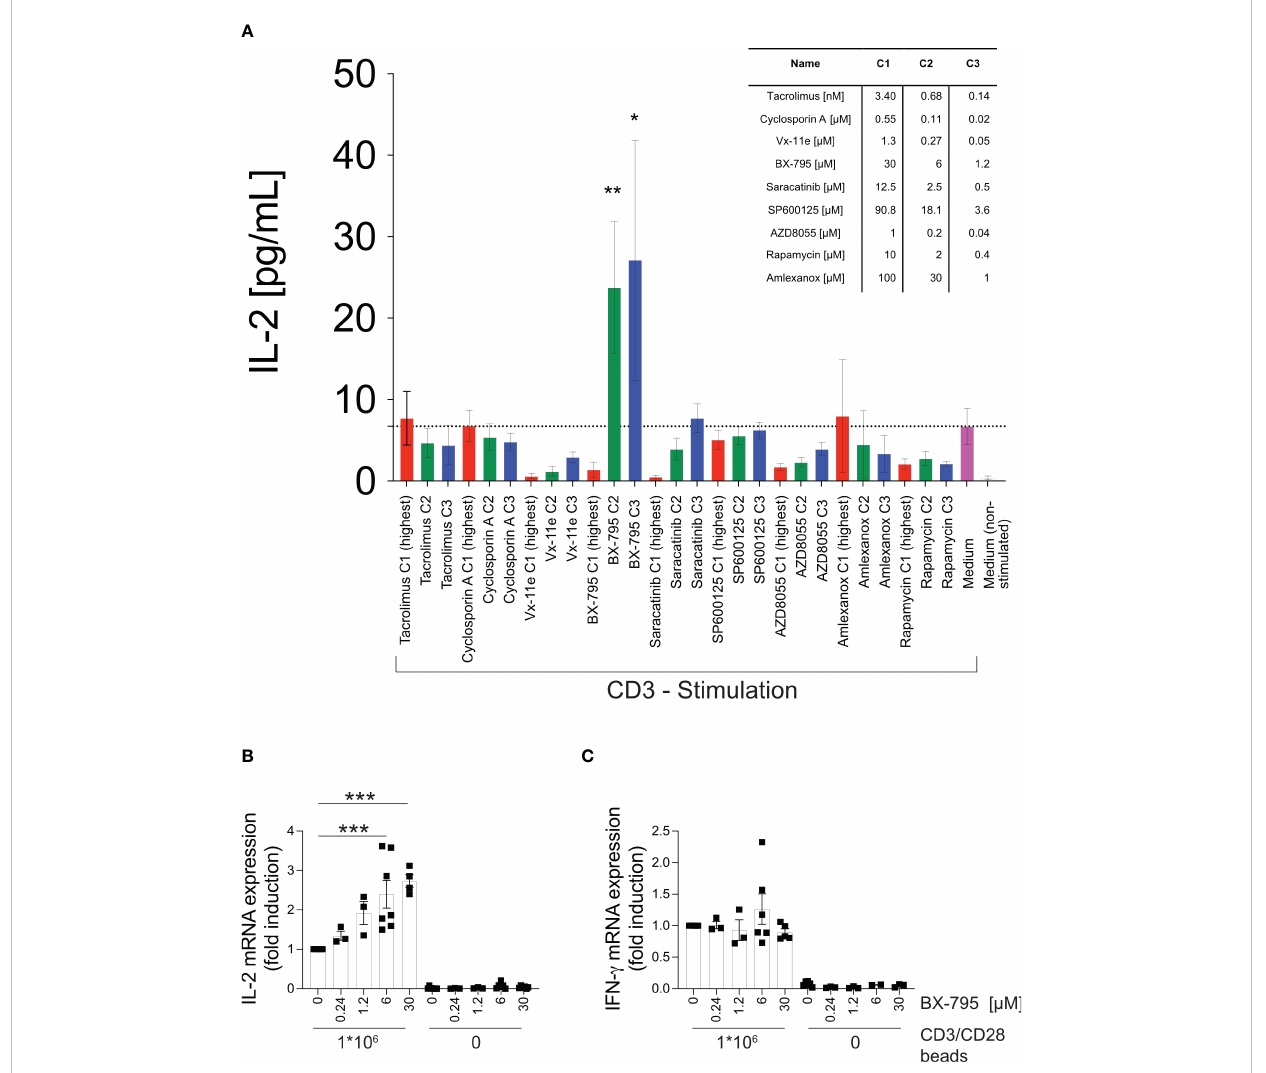
FIGURE 1 T cell activation studies identify BX-795 as a novel, IL-2 enhancing SMI which acts independently of accessory cells. Shown are (A) , IL-2 levels in supernatants of Jurkat E6-1 cells (1x10 5 cells/well) incubated in 96-well fl at bottom plates in the presence (colored bars) or absence (white bar) of plate-bound CD3 mAb OKT3 in the presence (red, green, blue) or absence (magenta and white bar) of the indicated SMI applied at the indicated fi nal concentrations C1 – C3 (see inset table, C1 red, C2 green, C3 blue). All conditions contained DMSO at a fi nal concentration of 0.25% (v/v). Shown are relative (B), IL-2 and (C), IFN- g mRNA expression levels as assessed by RT-qPCR of Jurkat E6-1 cells (1x10 6 cells/well in a 48 well plate, 400 µL fi nal volume) incubated in the presence or absence of CD3/CD28 beads (1x10 6 beads/well) and the indicated concentrations of BX-795 for 6 hours in 400 µL fi nal volume. Speci fi c mRNA levels were fi rst normalized to the housekeeping gene b -2 microglobulin ( b 2M) and then normalized to the mean of the CD3/CD28 beads stimulated DMSO condition for each respective experiment. All conditions contained DMSO at a fi nal concentration of 0.25% (v/v). Data show in A, mean values ± SEM of four independently performed experiments (except three for rapamycin, and two for amlexanox) tested in triplicates and in B, the summary (means ± SEM) of seven (except 3 for 0.24 and 1.2 µM; 4 for CD3/CD28 at 30 µM; and 6 for unstimulated 6 and 30 µM) independently performed experiments is shown. In (C) , the summary (means ± SEM) of six (except 5 for 30 µM; 3 for 0.24 and 1.2 µM; and 2 for unstimulated at 6 µM) are shown. One-way ANOVA with Dunnett ’ s correction for multiple comparisons (A) , comparing all conditions against CD3 stimulated cells in solvent (mean of CD3 stimulated control indicated by dotted line) and (B, C) , comparing the respective stimulated and BX-795 treated condition to the stimulated condition which was treated with solvent only. Statistically signi fi cant changes are indicated with *, p < 0.05; **, p < 0.01; ***, p <